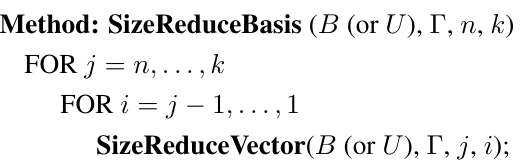
Figure 2. Size Reduction of a